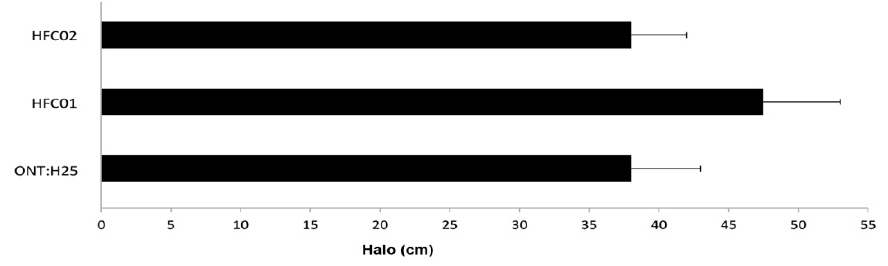
Figure 7. Motility from ONT:H25, HFC01 and HFC02 strains, after 8 h of incubation at 37 °C.